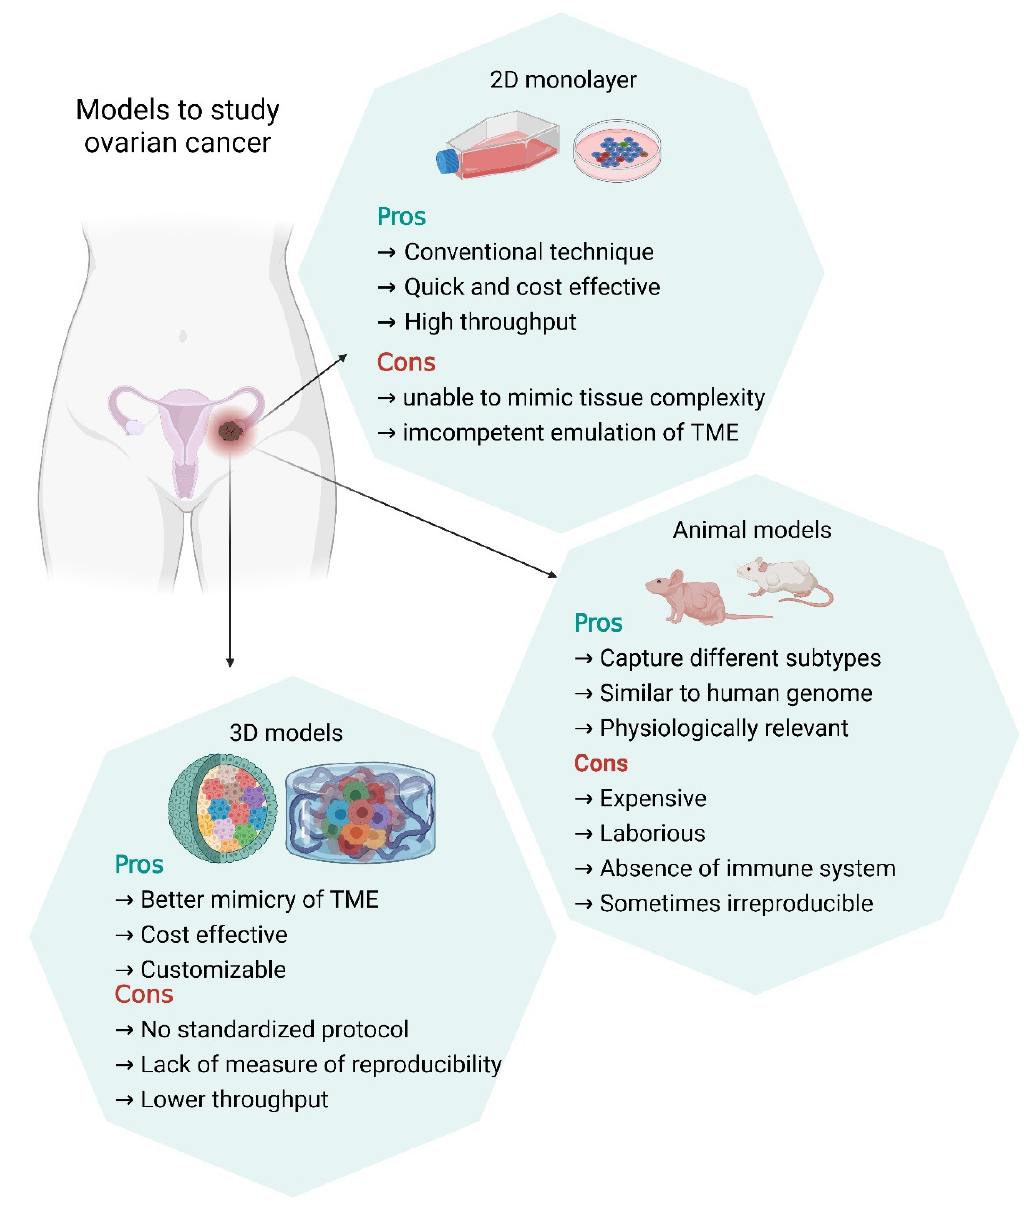
Figure 2. Advantages and disadvantages of the various models to study ovarian cancer. Created with BioRender.com.